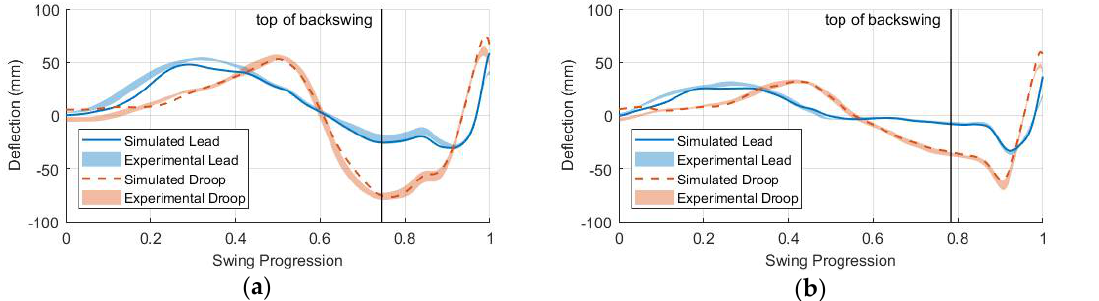
Figure 2. ( a ) Golfer A shaft deflections; ( b ) Golfer B shaft deflections.